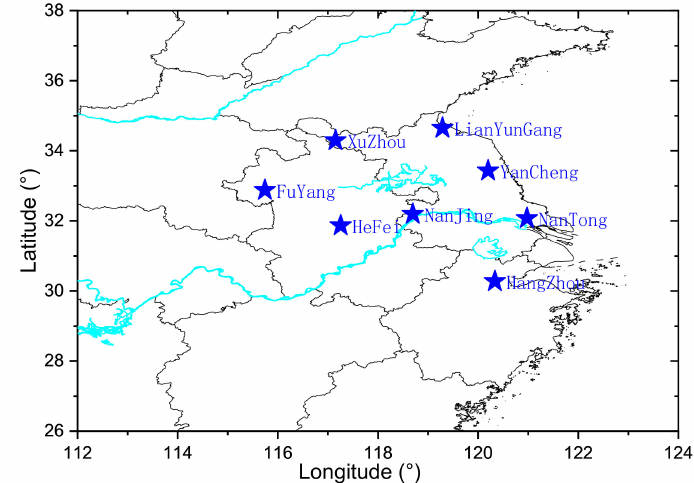
Figure 1. Diagram of eight S-band weather radars network in East